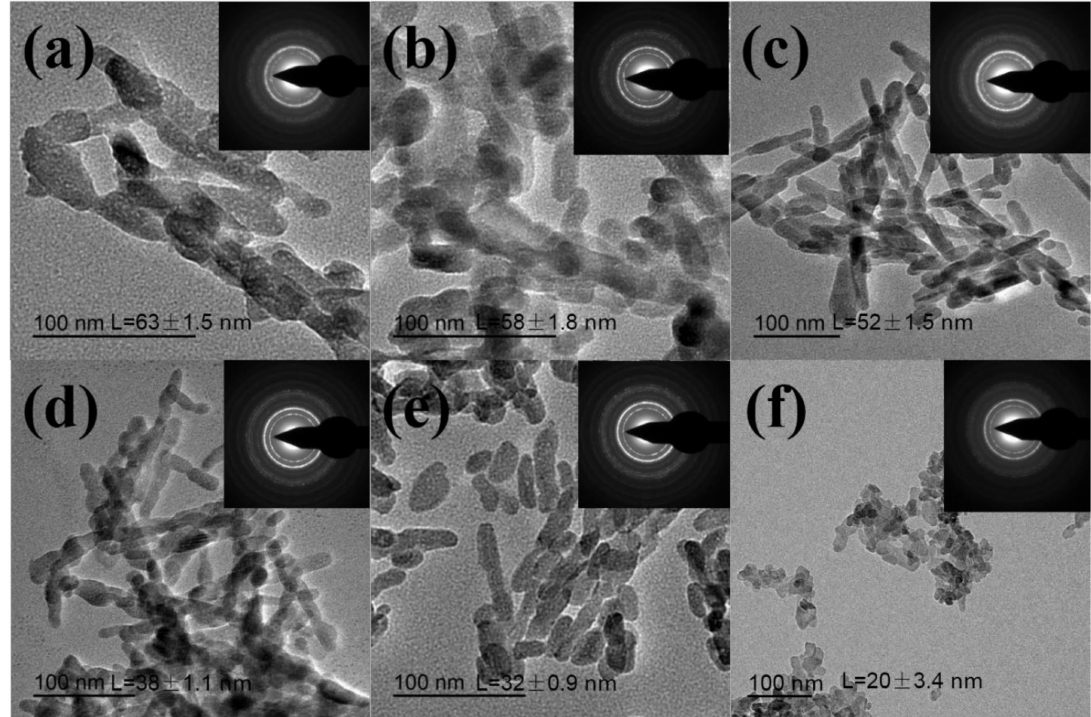
Figure 3. TEM and SEAD images of synthesized HA samples: ( a – e ) S1–S5 and HA derived from grass carp scales ( f )